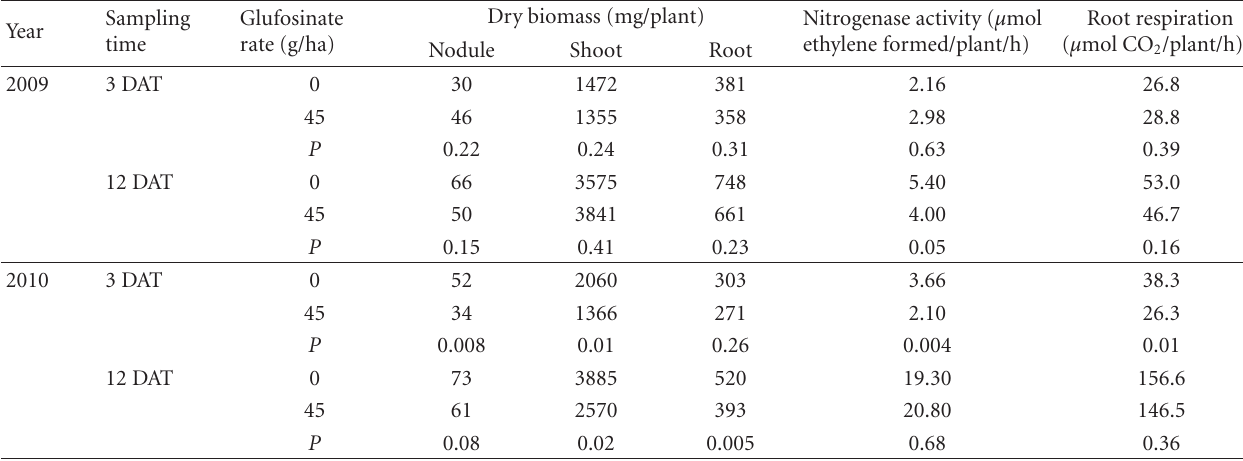
Table 3: Glufosinate e ff ect on shoot, root, and nodule biomass, nitrogenase activity, and root respiration in glyphosate-resistant soybean under field conditions in 2009 and 2010.